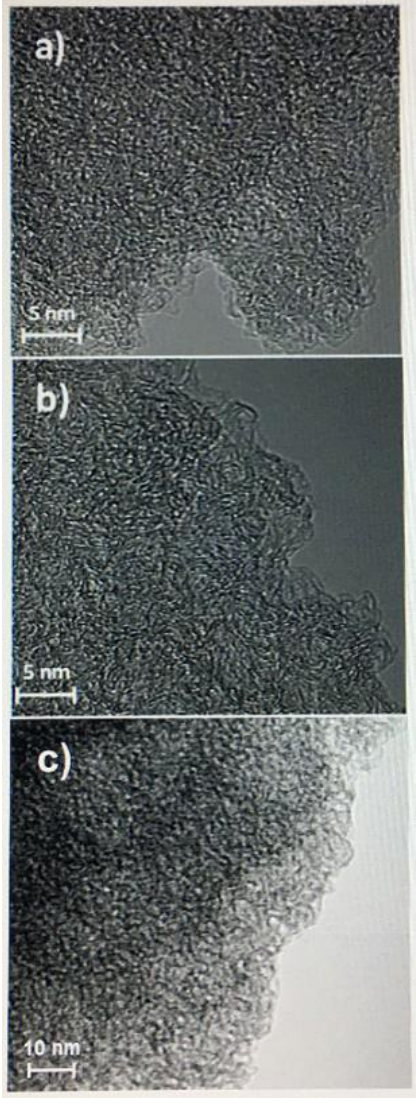
Figure 11. TEM images of carbonized benzoxazine films that are ( a ) BA-a- or ( b ) PH-ddm-based and ( c ) carbonized PI film (reproduced from the work in [58] with